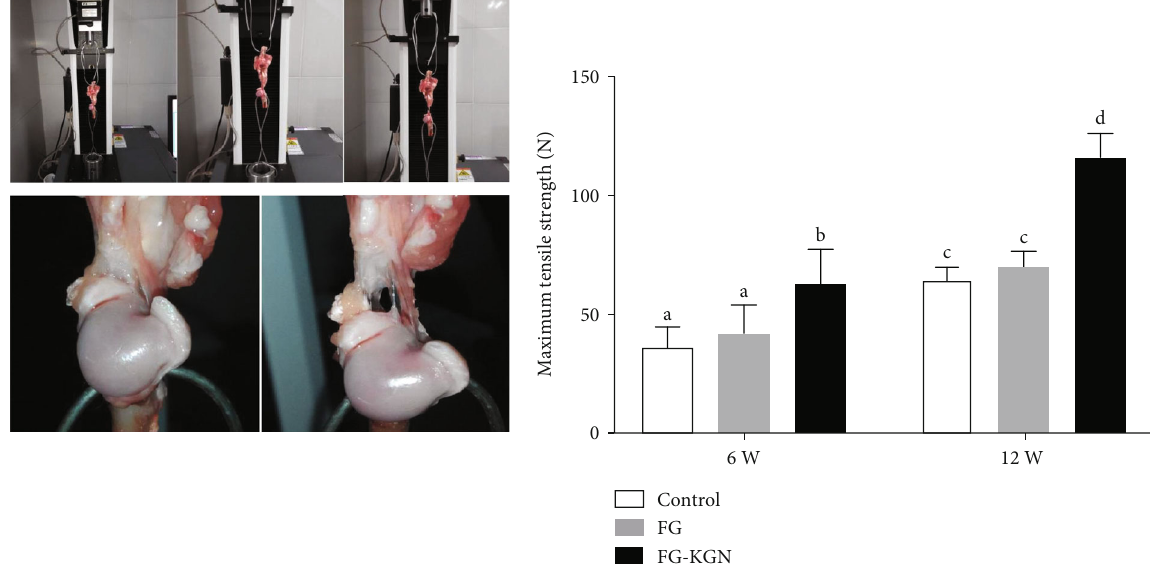
Figure 3: Biomechanical properties of the repaired rotator cu ff were tested by a mechanical tensile test. At 12 weeks, the maximum tensile strength of the FG-KGN group was signi fi cantly higher than that of the control group and the FG group (P < 0.01). Treatment with FG alone, however, did not signi fi cantly increase the strength over the control